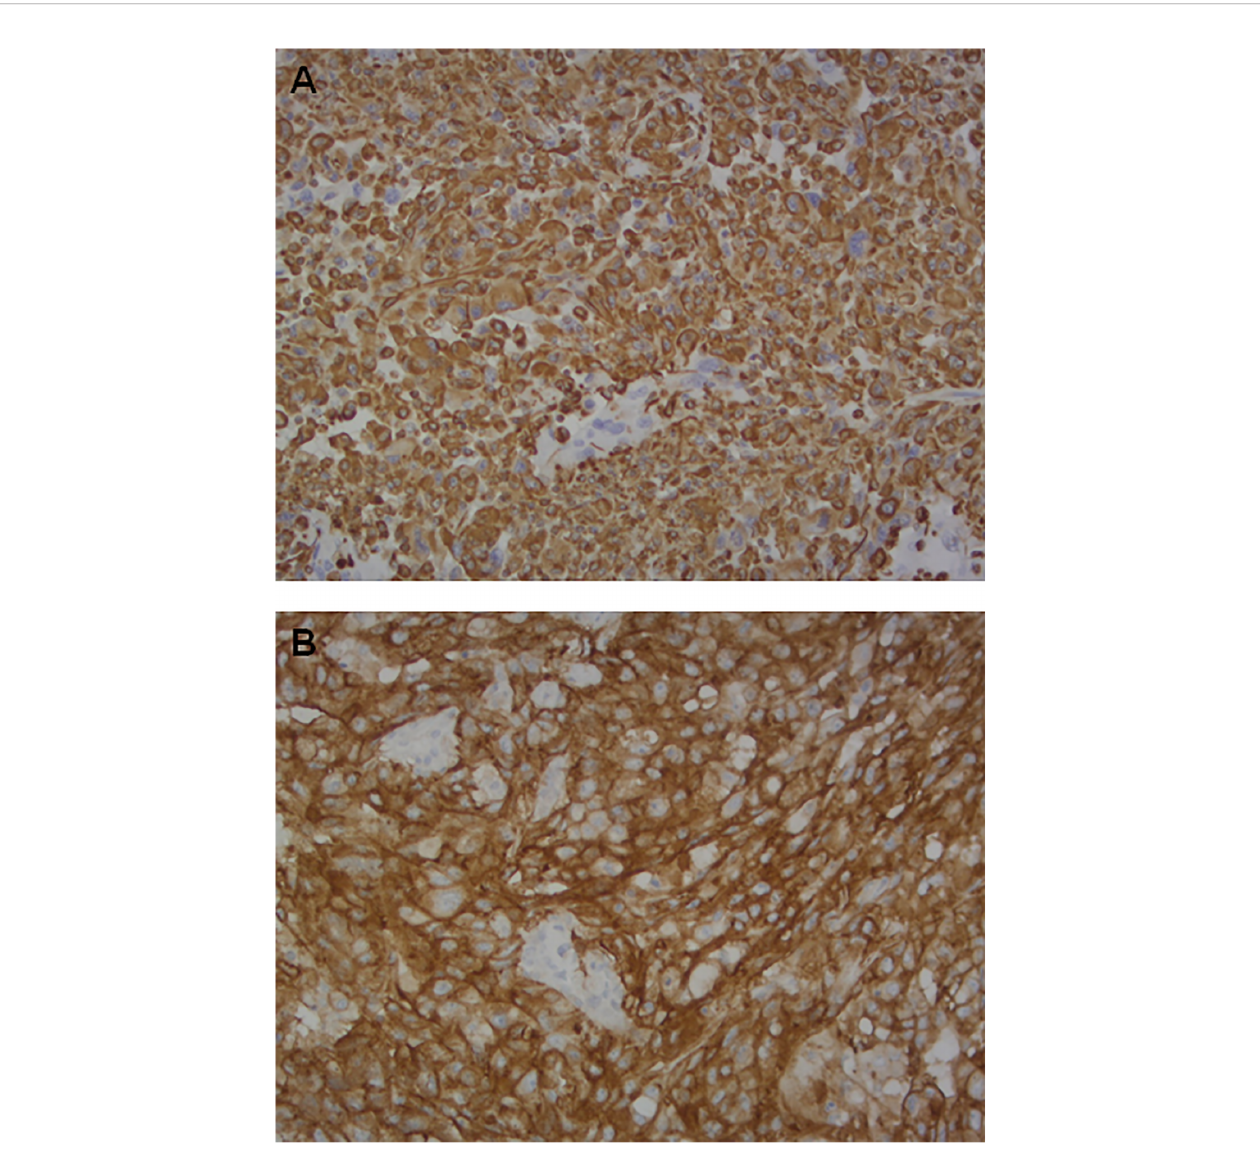
FIGURE 1 | Paraf fi n-embedded stained section of tissue samples showing similarly strongly positive epithelial cells from a patient with squamous cell carcinoma (SCC) of the lung stained on the Ventana BenchMark XT platform using: (A) SP263 Roche-Ventana antibody: PD-L1 (magni fi cation×20); (B) Con fi rm anti-Vimentin V9 antibody: vimentin (magni fi cation